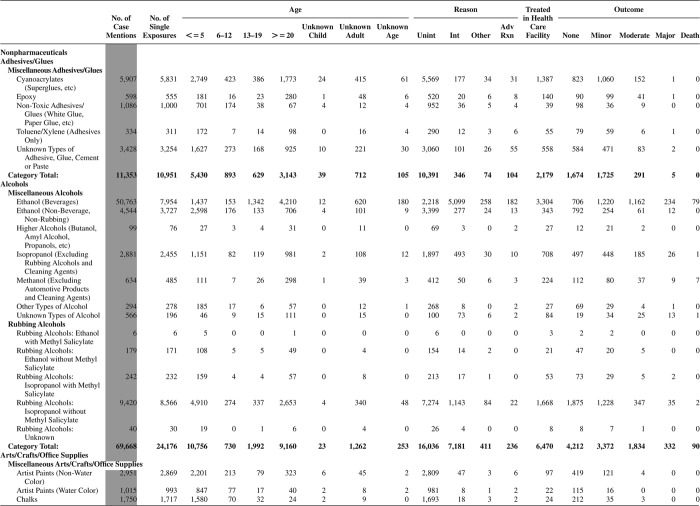
Demographic profile of SINGLE SUBSTANCE Nonpharmaceuticals exposure cases by generic category.